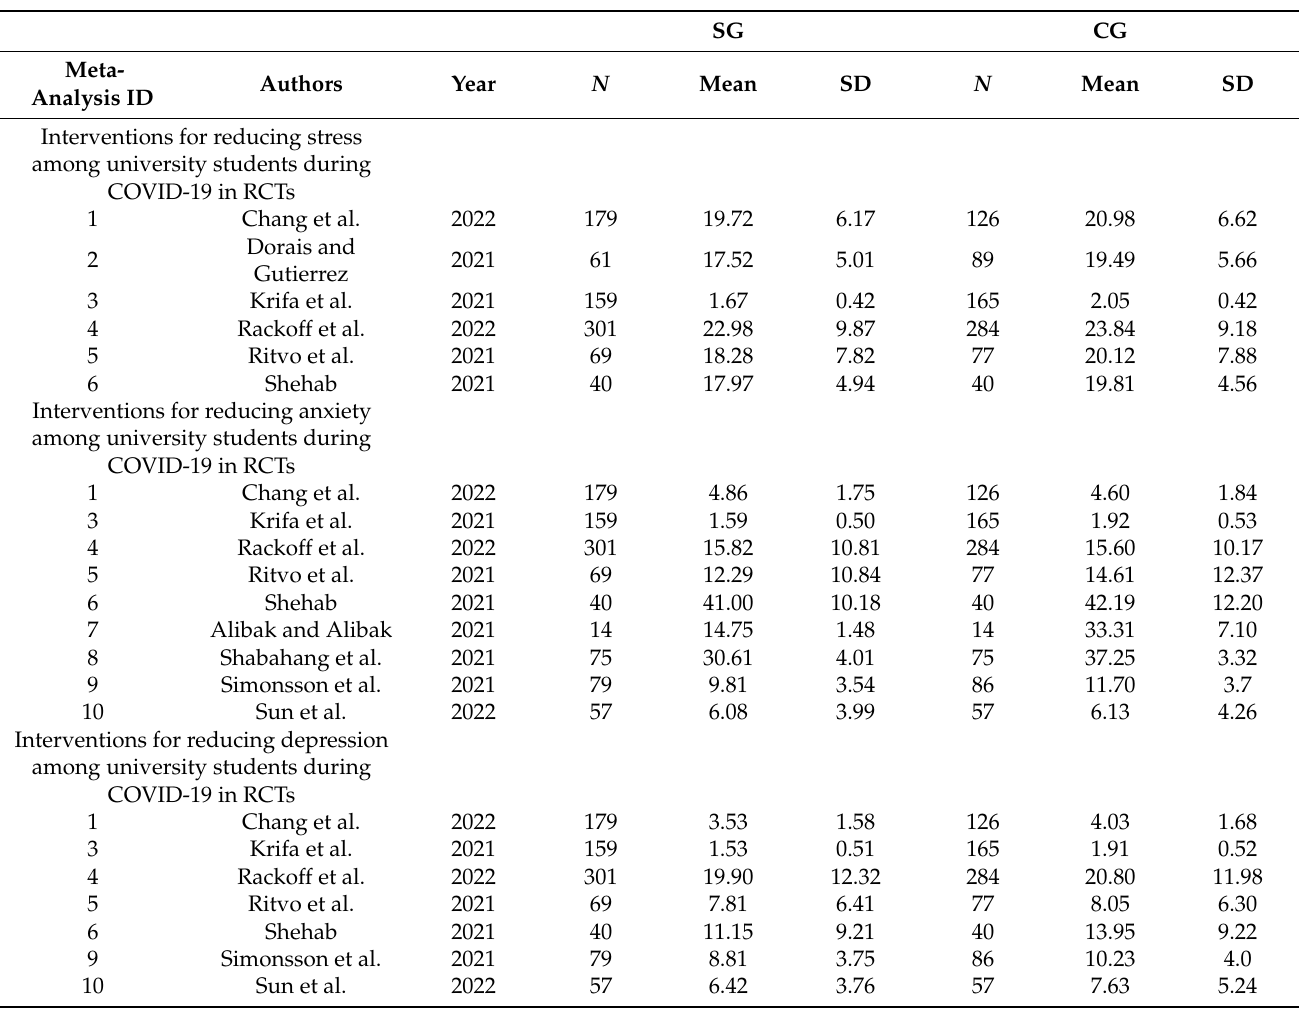
Table 2. Interventions for reducing the stress, anxiety, and depression of university students in the randomized controlled trials included in the meta-analysis. SG CG